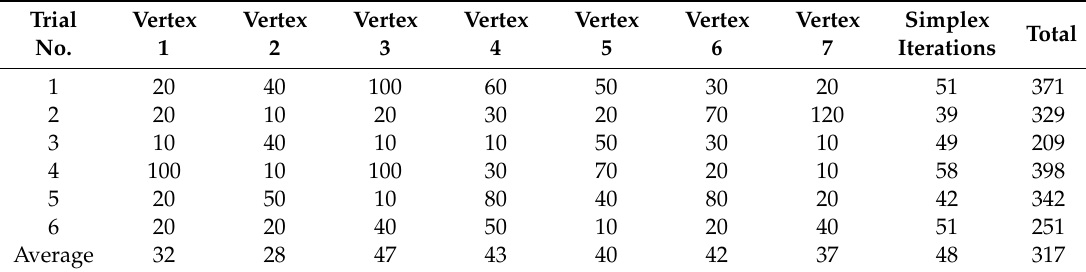
Table 8. Number of iterations required by PSO to obtain maximum targeted error for further application of Simplex